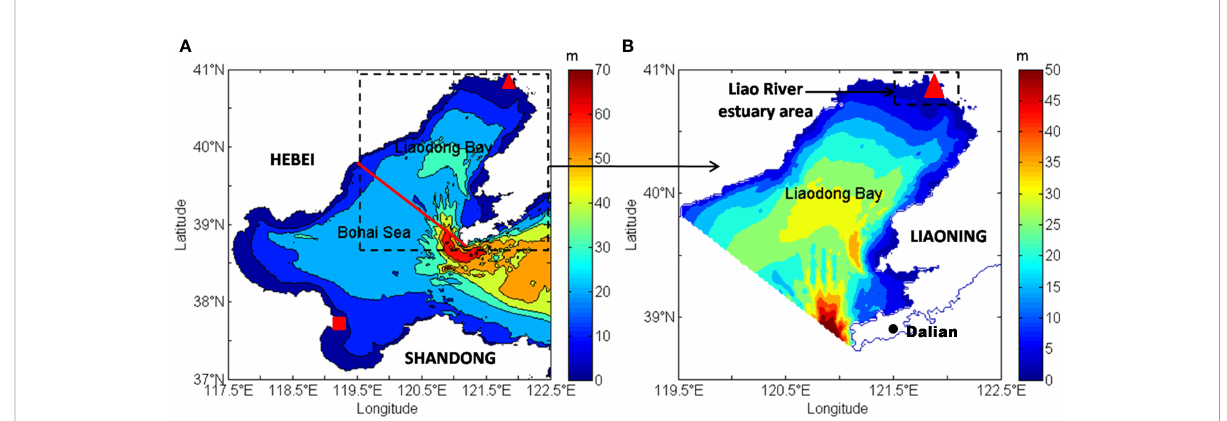
FIGURE 1 Geographical locations and bathymetry of the Bohai Sea and the Liaodong Bay. (A) shows the Bohai Sea, in which the red solid line is the boundary between the Liaodong Bay and the central Bohai Sea. The northwest end of the boundary is Qinhuangdao and the southeast end of the boundary is the Laotieshan Cape. The red triangle points out the estuary of the Liao River and the red square stands for the estuary of the Yellow River. The Liaodong Bay is selected using the black dotted line. (B) shows the study area, which is the Liaodong Bay. The red triangle still represents the estuary of the Liao River. The land on northwest side is Hebei Province and the land on the southeast side is Liaoning Province. Dalian city is located at the east of the mouth of the Liaodong Bay. The depth of the Liaodong Bay is deep in the central area and shallow around. The deepest region is near the mouth of the bay and the depth is more than